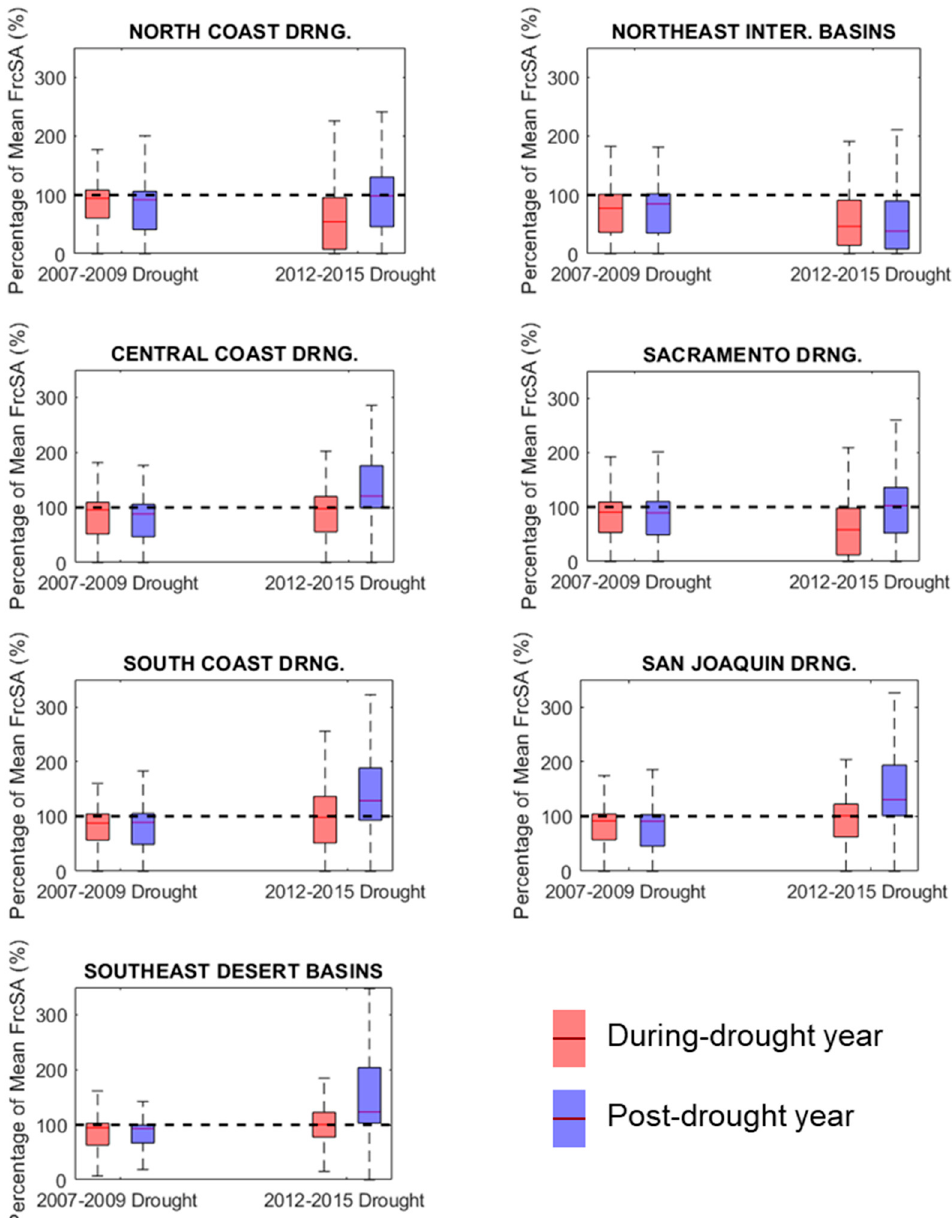
Figure 8. Normalized FrcSA (by long-term mean) of reaches in one year during droughts and one year after droughts for the 2007–2009 and 2012–2015 droughts and the seven climate divisions.